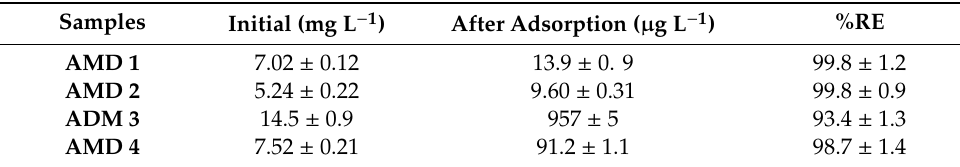
Table 5. Concentration of As in real samples, n =